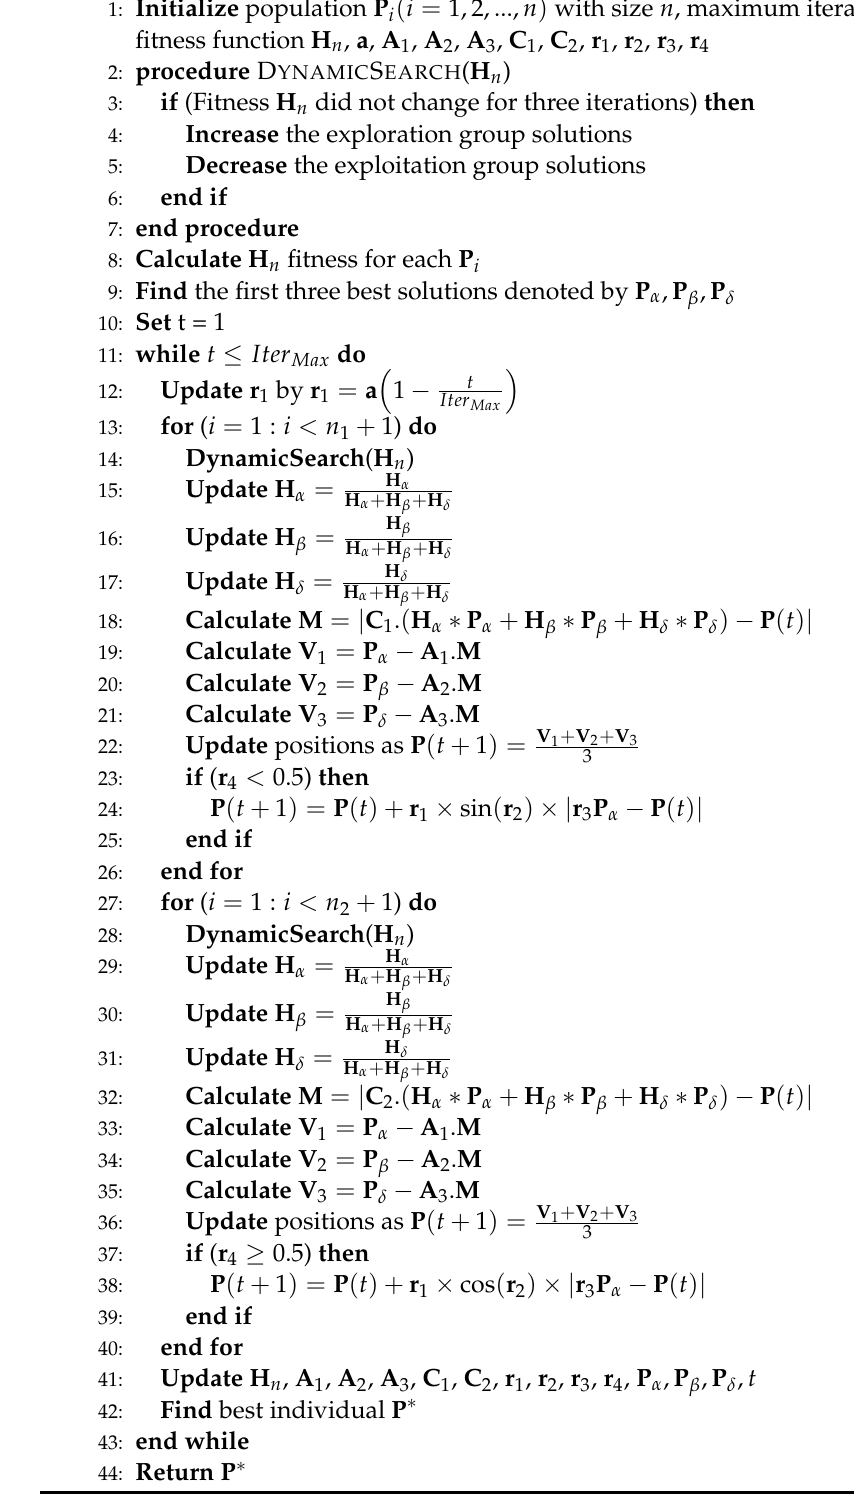
Algorithm 1: The proposed ADSCFGWO